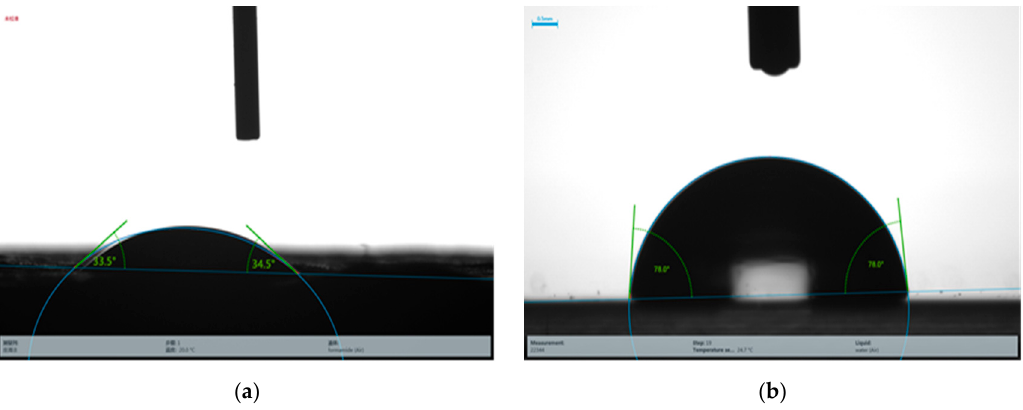
Figure 6. Contact angle of rock specimen before and after modification: ( a ) Virgin; ( b ) modification.